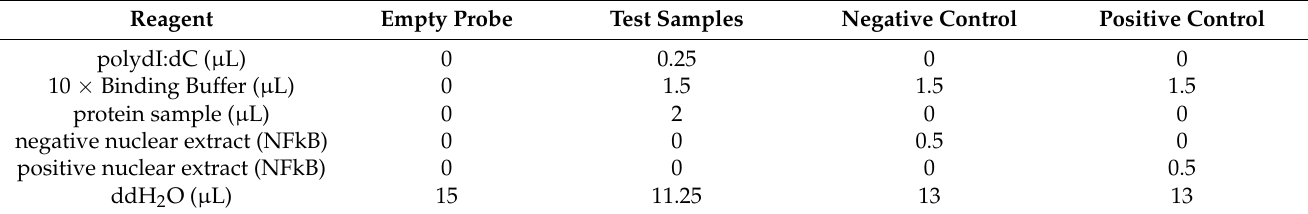
Table 16. EMSA reaction system.